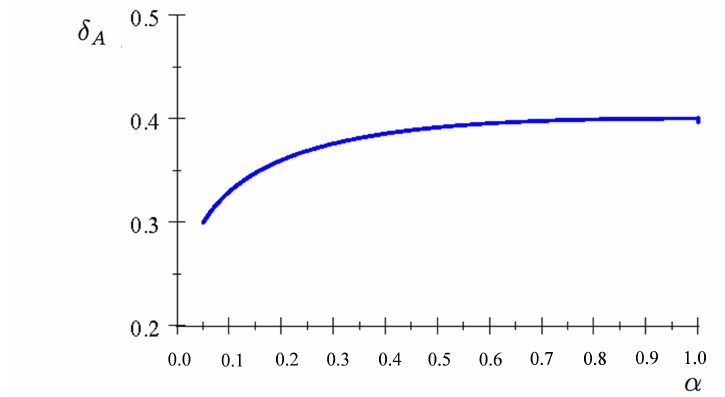
Figure 3. The critical discount factor for cooperation between altruists in the repeated